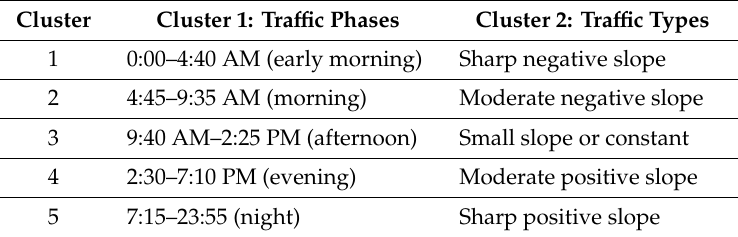
Table 1. Two cluster sets and their definitions.